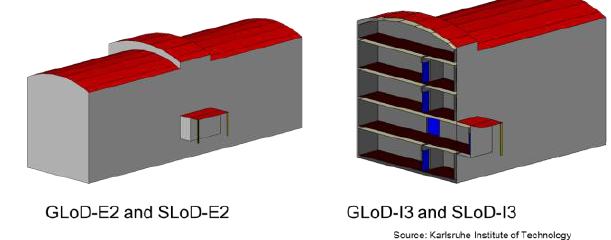
Figure 16: Representation of the exterior shell with generalised